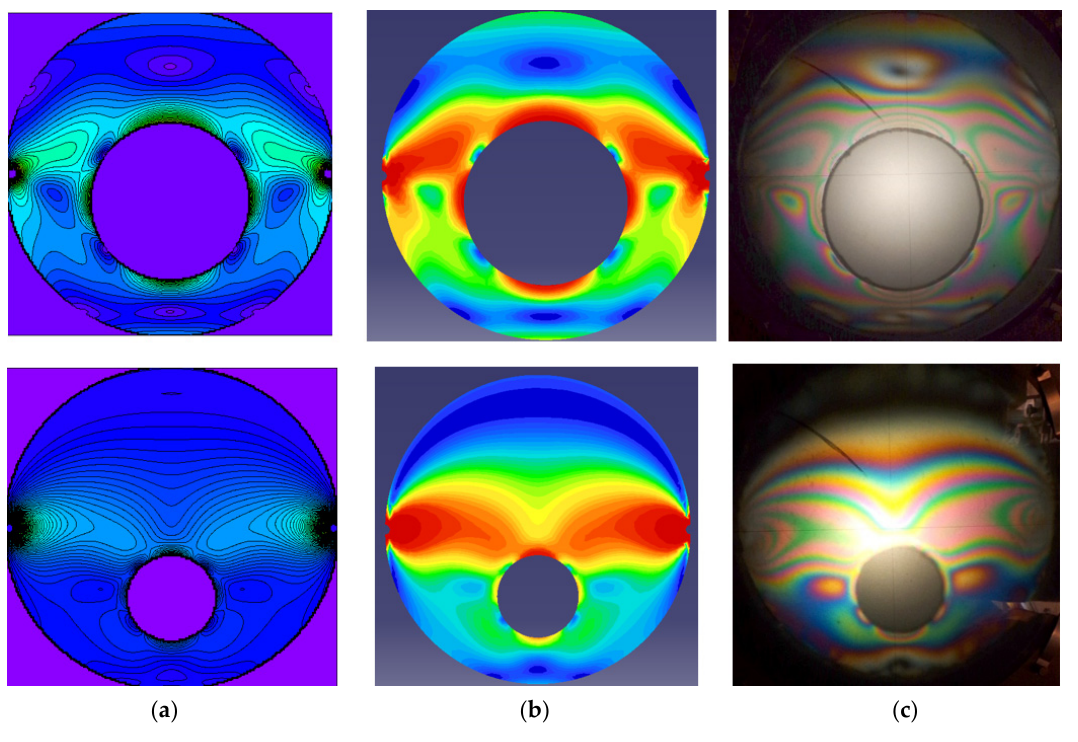
Figure 16. Isochromatic fields for two geometries of the ring compressed normally to the direction of the centres (loading Case b, Table 1): theoretical ( a ), numerical ( b ) and experimental ( c ) results.